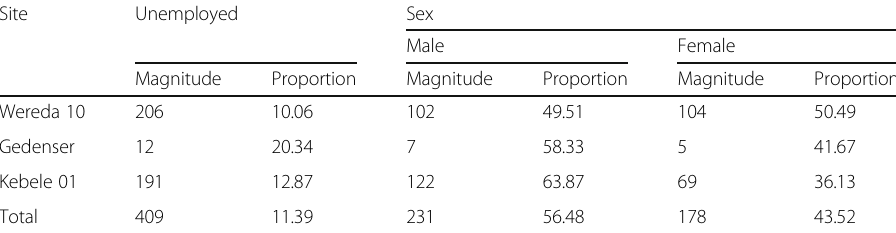
Table 1 Youth unemployment status by gender and study sites